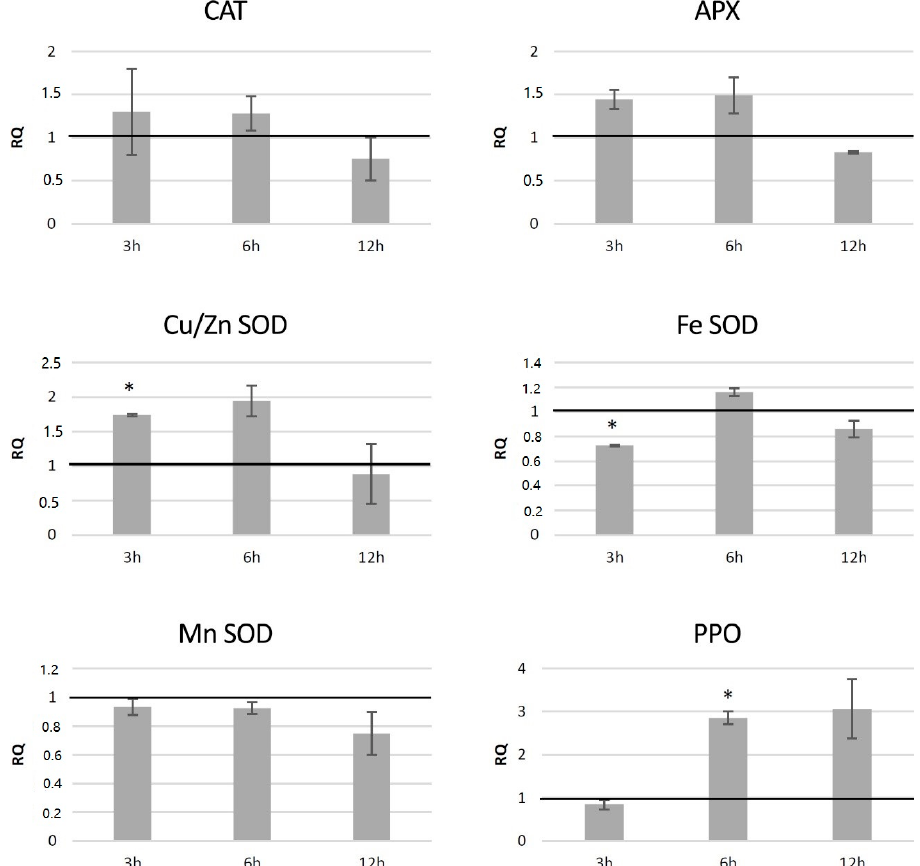
Figure 9. The level of transcript of genes involved in free radical processing ( CAT —catalase, APX —ascorbate peroxidase, SOD —superoxide dismutase, and PPO —polyphenol oxidase) in wild-type potato plants treated with 0.1 mg/mL L -DOPA presented as relative quantification (RQ) in relation to the non-treated control (horizontal line at RQ = 1). The elongation factor gene was used as a reference gene. The results were obtained with the RT-qPCR method on the cDNA matrix as the mean values of three biological repeats ± standard deviation. Statistically significant changes ( p < 0.05) are marked with asterisks.